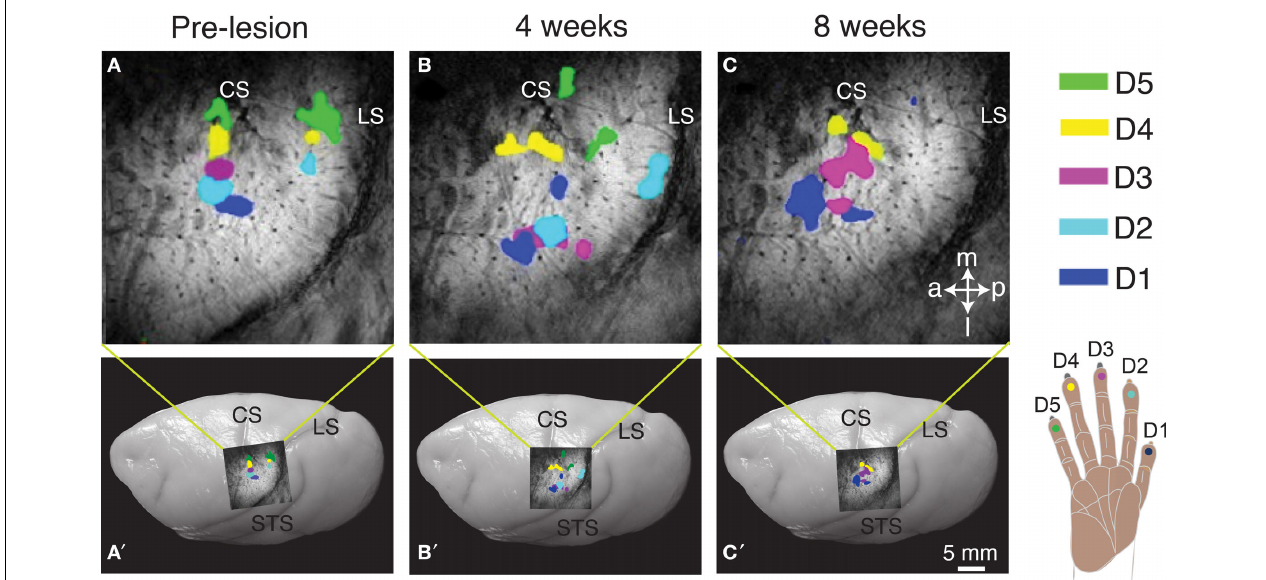
FIGURE 2 | Longitudinal mapping of fMRI activation to vibrotactile stimulation on digits 1–5 pre-lesion (A) and after 4-weeks (B) and 8-weeks (C) post-lesion following unilateral dorsal column section in a squirrel monkey (SM-O). Activation foci from trial blocks of stimulation on individual digits were superimposed for the composite images (A–C) . The location of the top panel on the brain is shown for each panel below. Dots on the hand